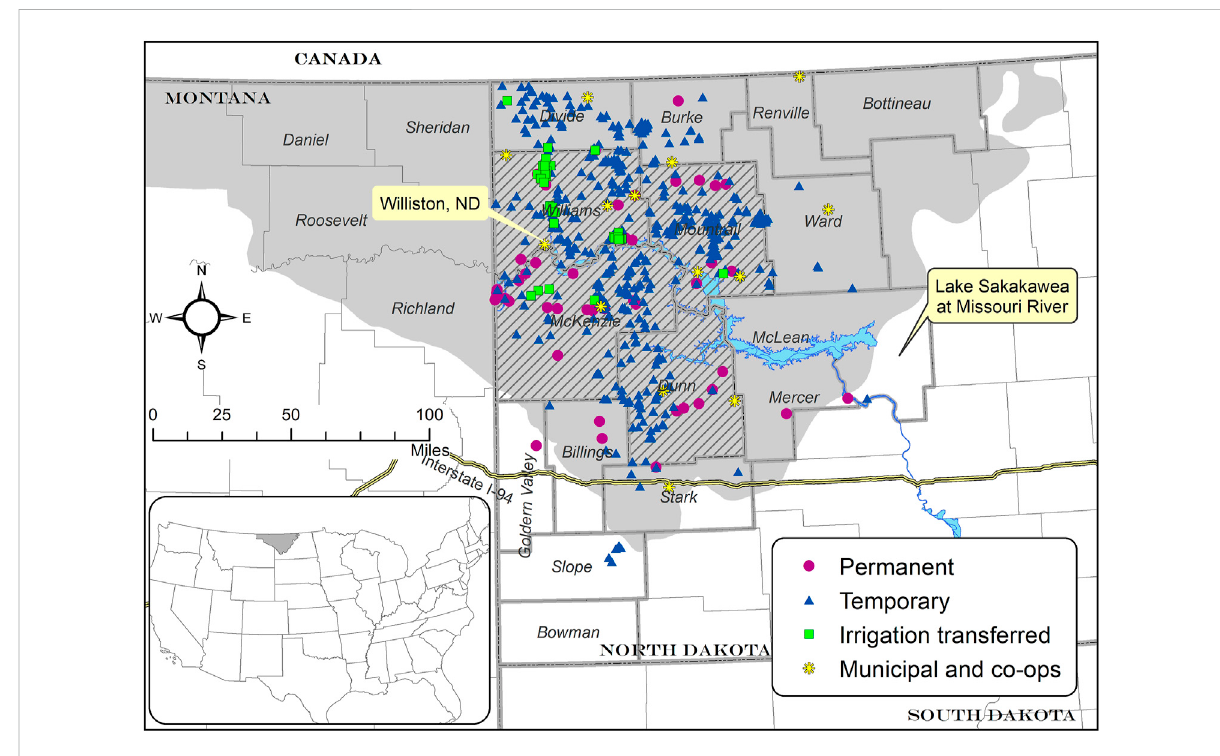
FIGURE 2 Water depots in Western North Dakota